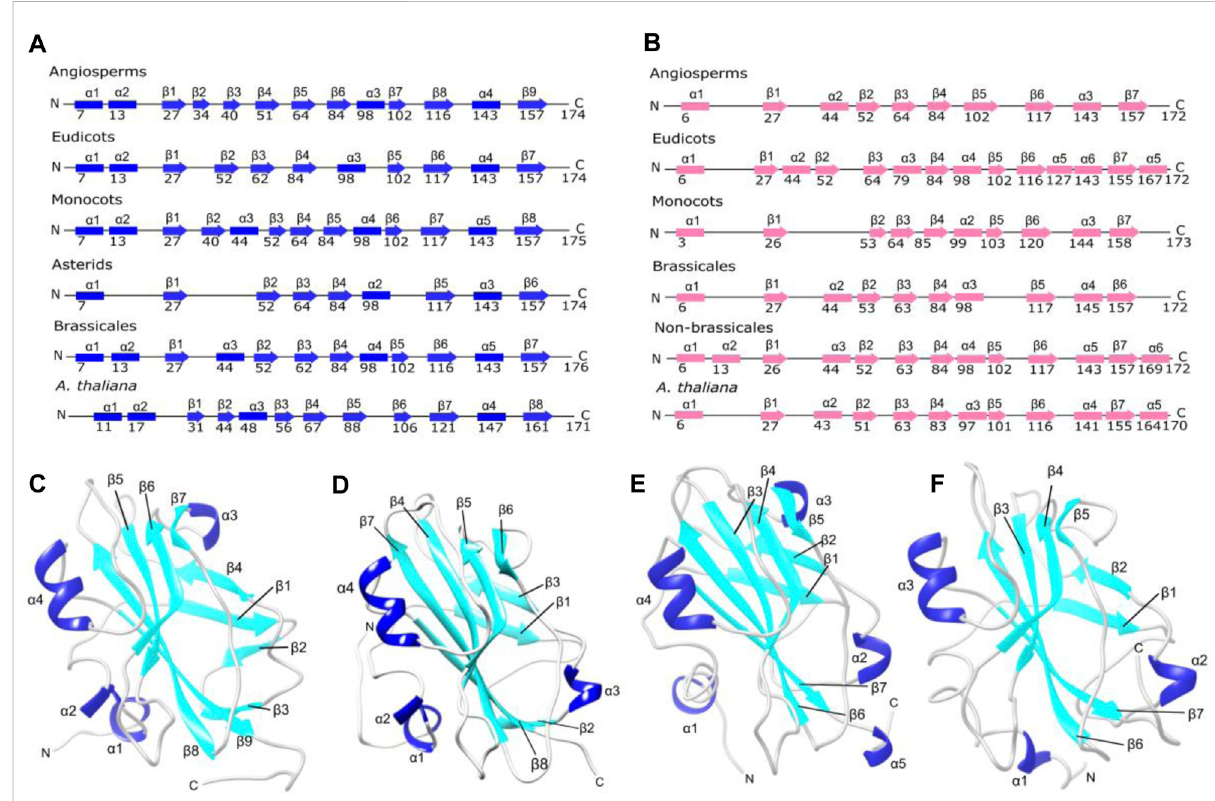
FIGURE 3 Protein secondary and tertiary structures of FT and TFL1 (A) Secondary structures of inferred ancestral and A. thaliana FT. (B) Secondary structures of ancestral and A. thaliana TFL1 (C) Tertiary structure of the inferred ancestral of angiosperm clade FT. (D) Tertiary structure of A. thaliana FT (E) Tertiary structure of A. thaliana TFL1. (F) Tertiary structure of the inferred ancestral of angiosperm clade